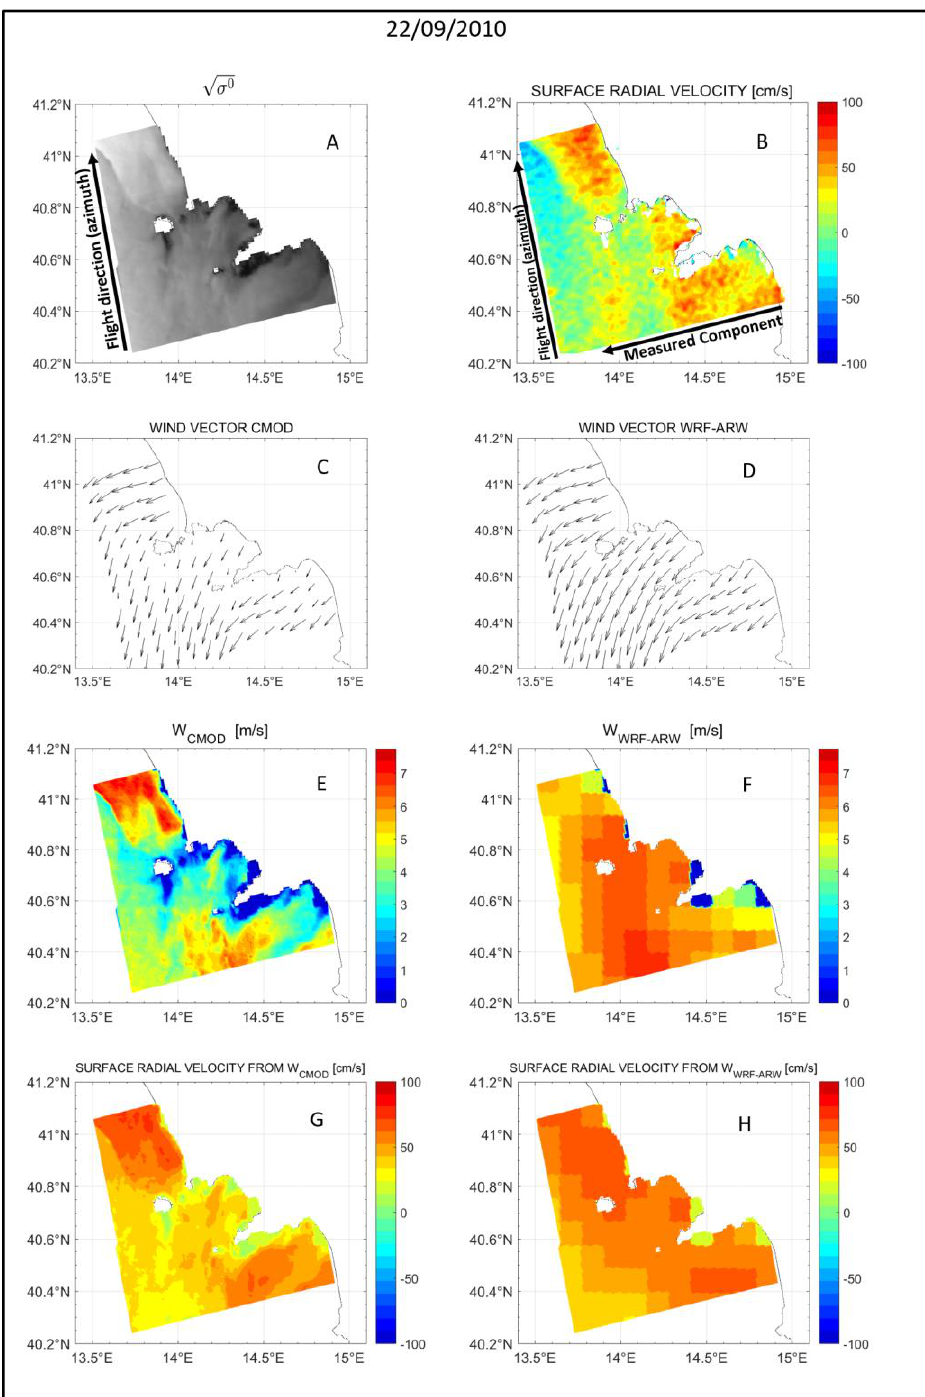
Figure 10. Results related to the acquisition of 22/09/2010. The image is divided as follow: ( A ) is the σ 0 ; ( B ) is the estimated Doppler Anomaly maps of the marine area converted into the line-of-sight component of the sea surface velocity; ( C ) is the wind direction obtained from the CMOD model; ( D ) is the wind direction obtained from the WRF-ARW model; ( E ) is the wind speed relative to the CMOD model; ( F ) is the wind speed relative to the WRF-ARW model; ( G ) and ( H ) is the surface radial velocity due to the wind component, evaluated as descried in Section 4, for the CMOD model and for the WRF-ARW model, respectively.